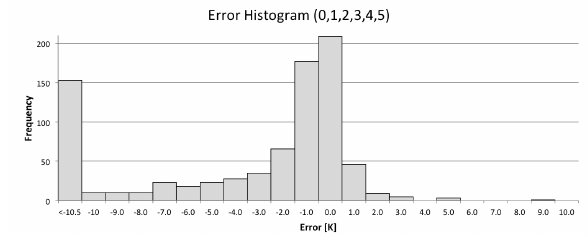
Figure 3: Error histogram for all images in Landsat 5 validation dataset.